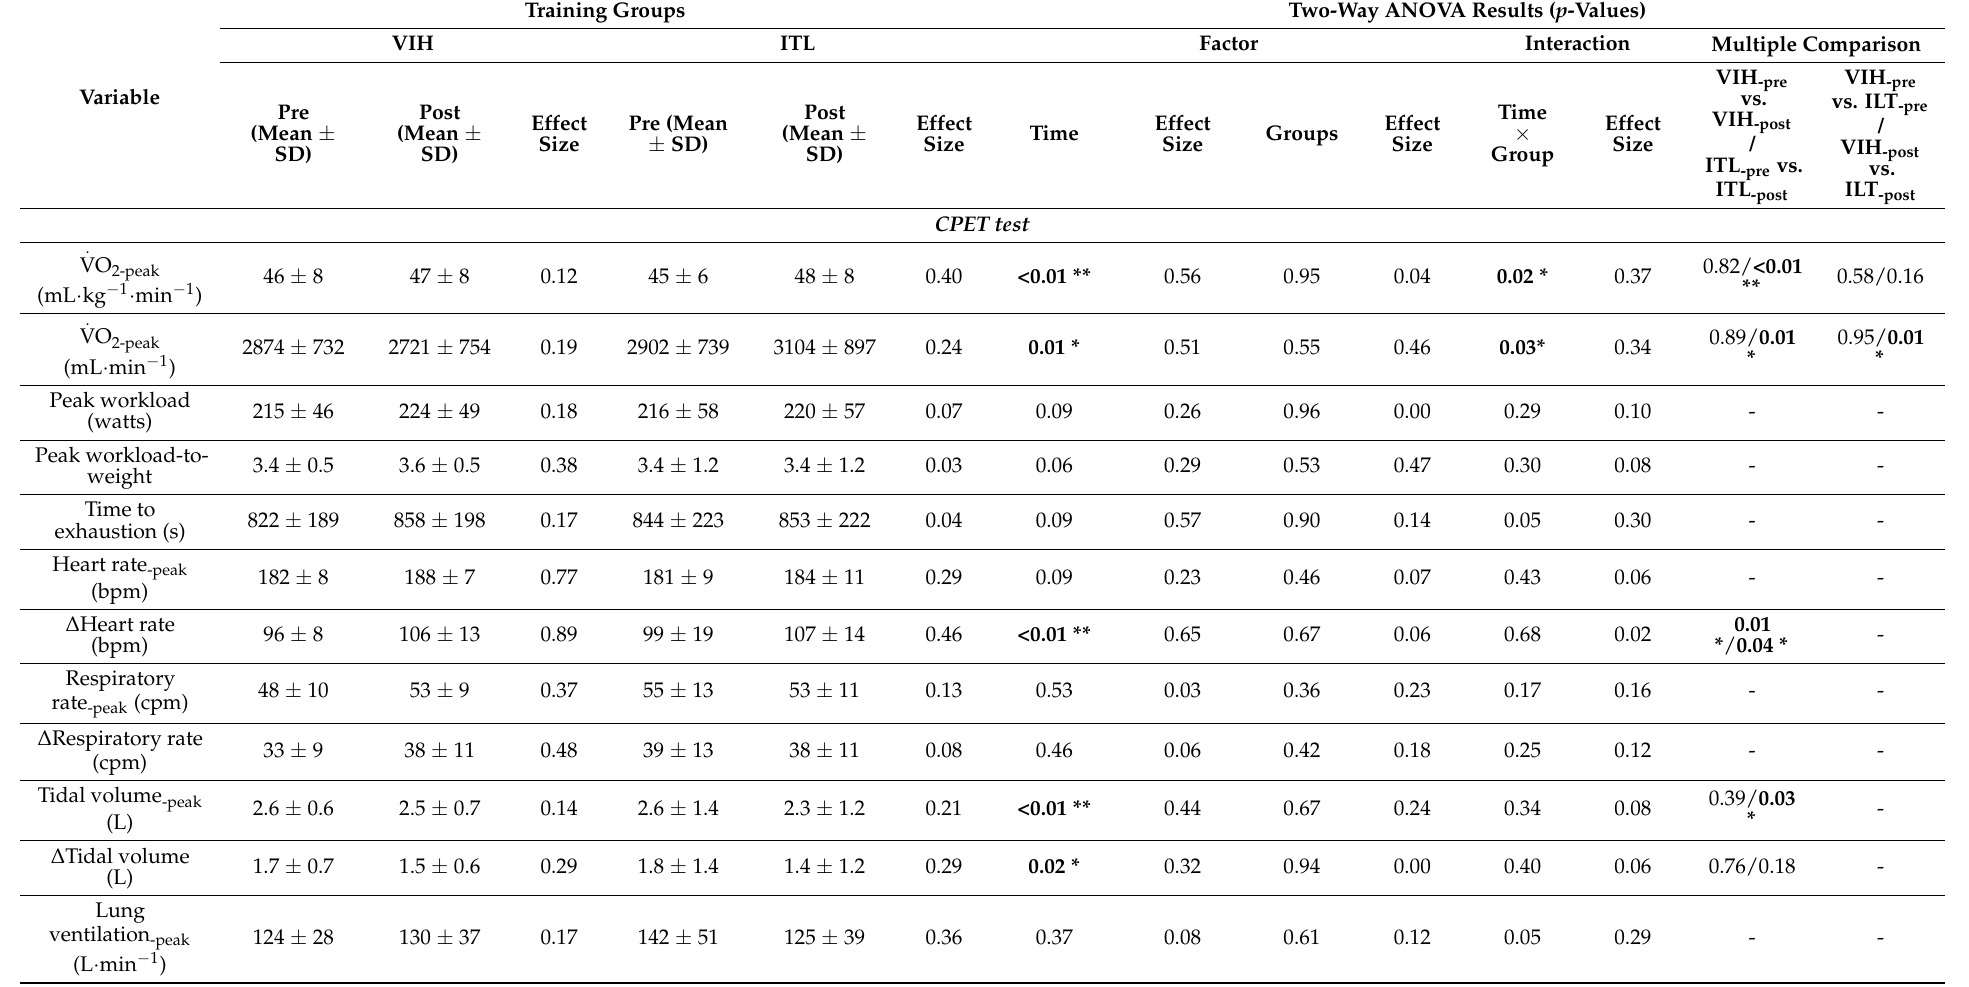
Table 2. Changes in CPET, Spirometry, respiratory muscle performance, muscle oxygenation, and related